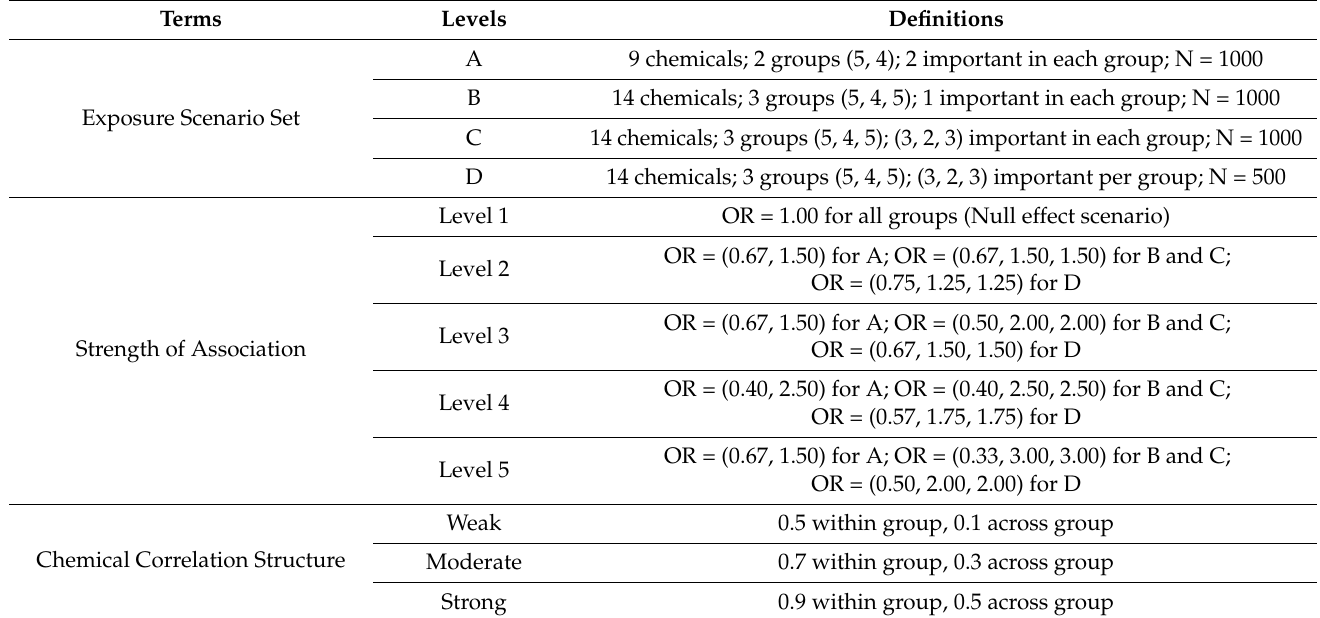
Table 1. Definition of the terms used in the simulation study exposure